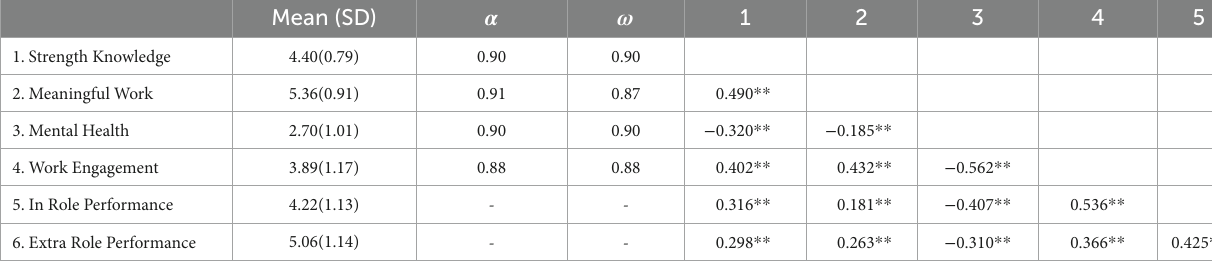
TABLE 4 Descriptive statistics, reliability coefficients, and Pearson’s correlations for all study 2 variables.